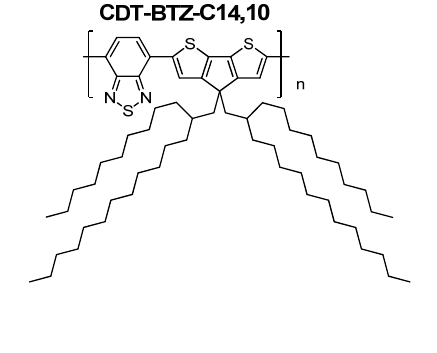
Figure 1. Structure of CDT-BTZ with branched side